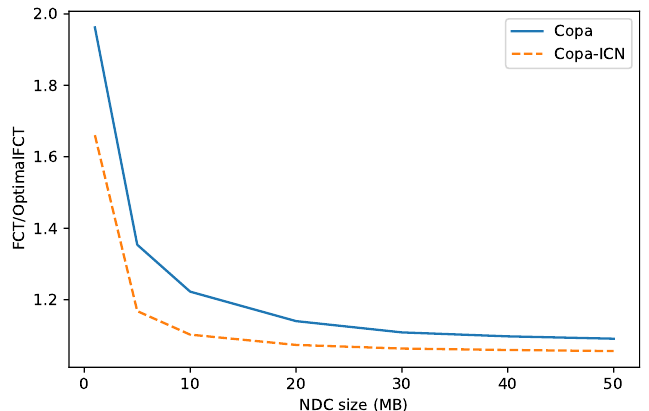
Figure 13. The ratio of the FCT to the optimal value for NDCs of different